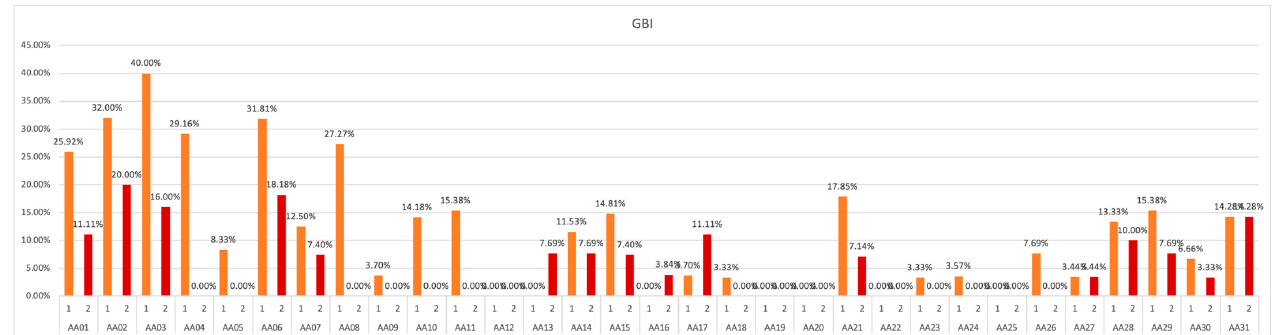
Figure 10. GBI values obtained in subsequent measurements over the course of study.